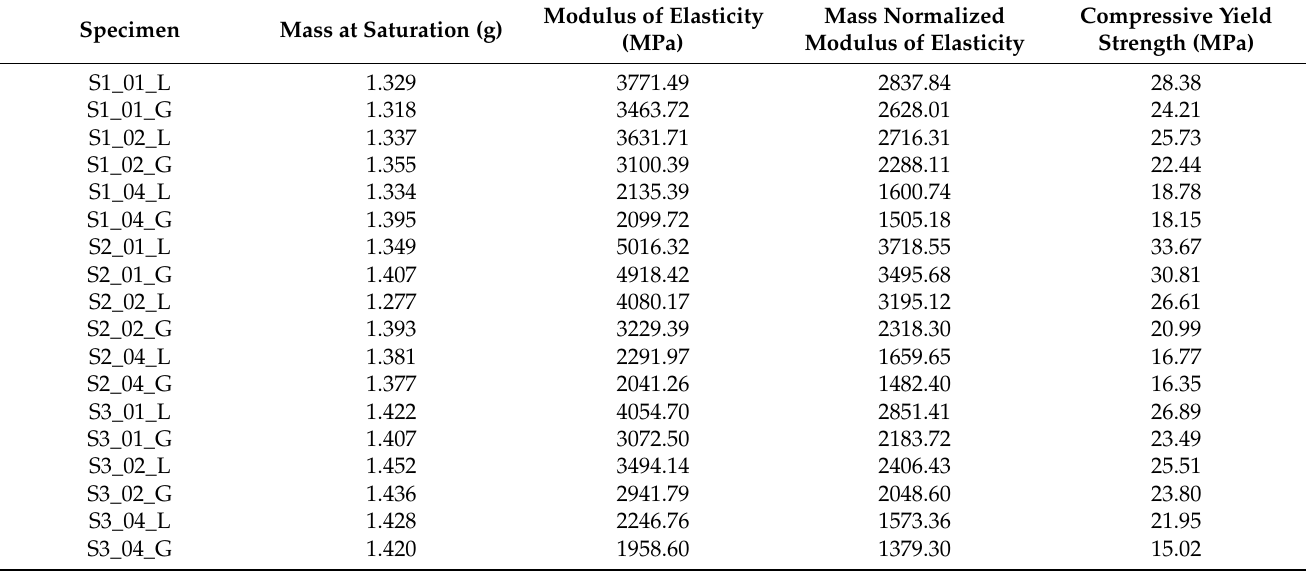
Table 4. Compression results of the disinfected ABS